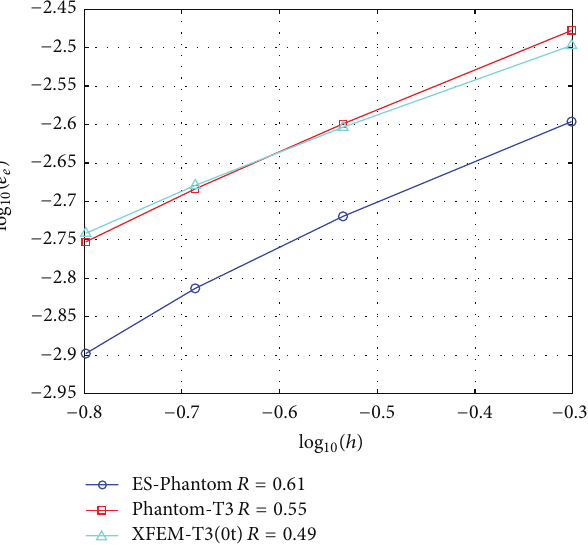
Figure 16: Sheet with edge crack under shear.